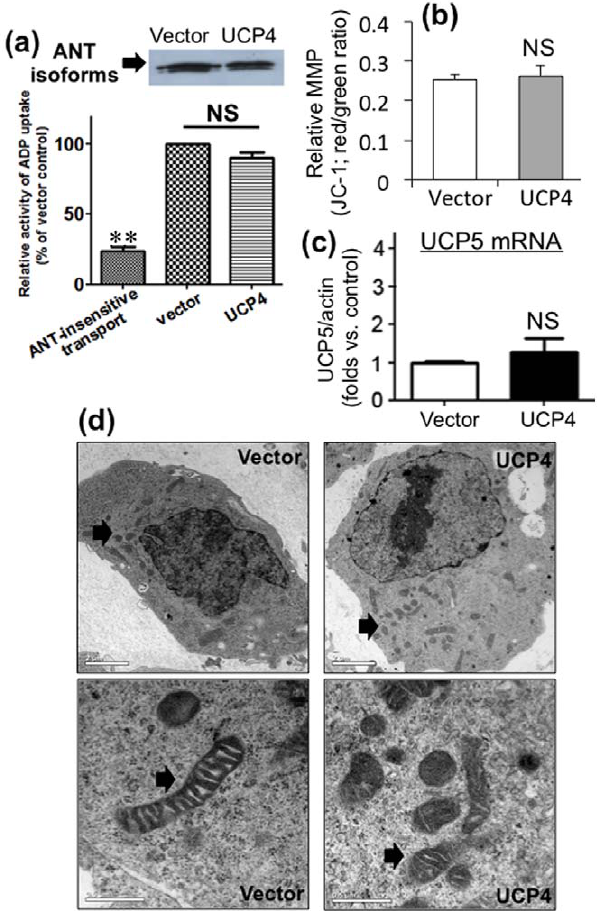
Figure 7. Relative changes of ADP/ATP exchange activity, ADP consumption and mitochondrial membrane potential in UCP4- overexpressing cells. (a) ANT activity in vector control and UCP4- overexpressing cells was determined using radioactive [ 14 C]ADP uptake assay in isolated mitochondria. The ANT activities in both vector and UCP4-overexpressing cells were similar. Protein expression of ANT was also similar in both cell types. (b) ADP consumption in isolated mitochondria from vector control and UCP4-overexpressing cells. UCP4- overexpressing mitochondria consumed more ADP by succinate- induced state 3 respiration. (c) Relative mitochondrial membrane potential in vector control and UCP4-overexpressing cells were similar, as determined by ratiometric (red/green ratio) measurement of JC-1 using spectrophotometry. (d) No corresponding change in UCP5 (neuronal UCP homologue of UCP4) mRNA expression in UCP4- overexpressing cells compared to vector control as shown by quantitative RT-PCR. Results are expressed as mean 6 SEM based on three independent trials. ** represents statistical significance at p , 0.01, * represents p , 0.05, compared to the vector control cells. NS: not significant. (e) Morphology, intracellular distribution, and ultrastructure of mitochondria in vector control and UCP4-overexpressing SH-SY5Y cells were evaluated by transmission electron microscopy (TEM) at magnification of 1:1650 and 1:8900. The mitochondrial morphology, intracellular distribution and ultrastructure were similar in vector control and UCP4-overexpressing cells. ( Arrow :